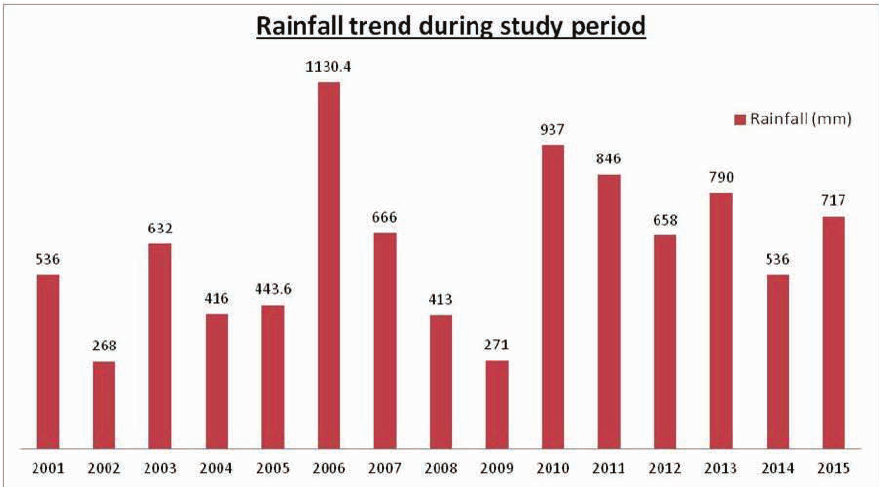
Figure 3: Rainfall trend during the study period